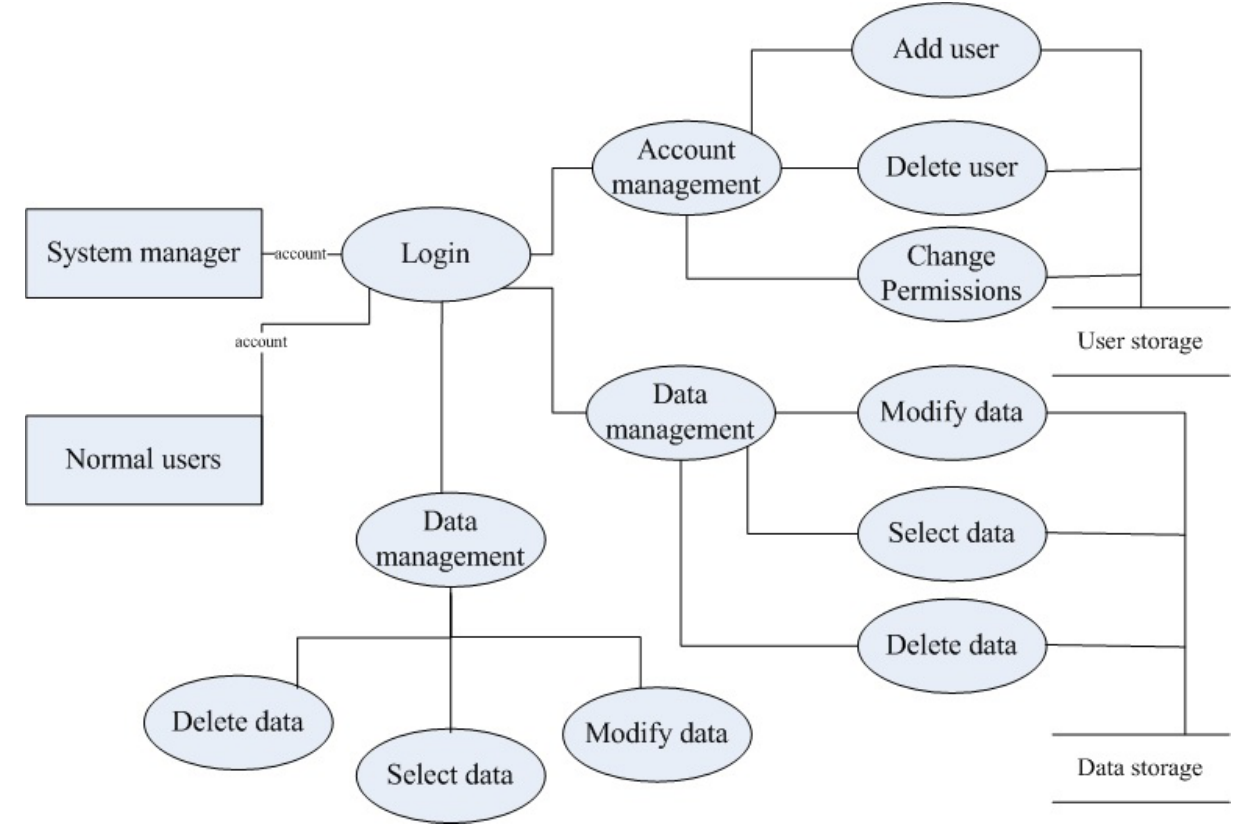
Figure 4. Data flow diagram of database management.